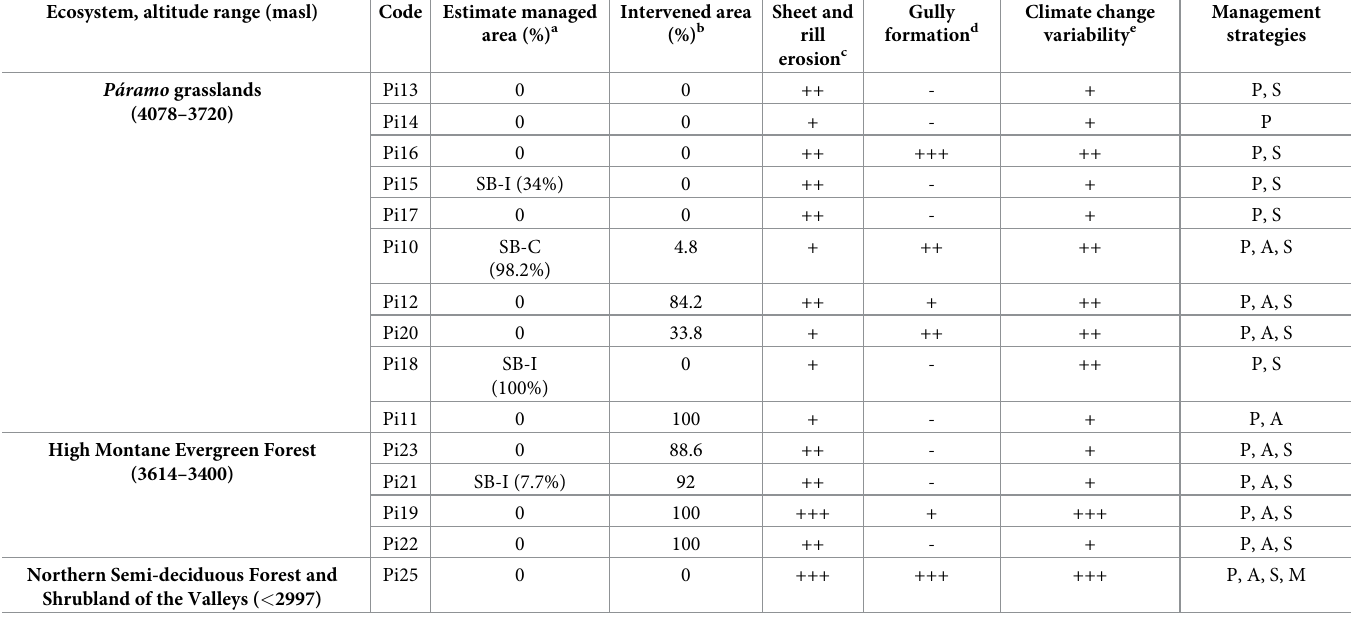
Table 9. Suggested strategies based on susceptibility to rain erosion. Ecosystem, altitude range